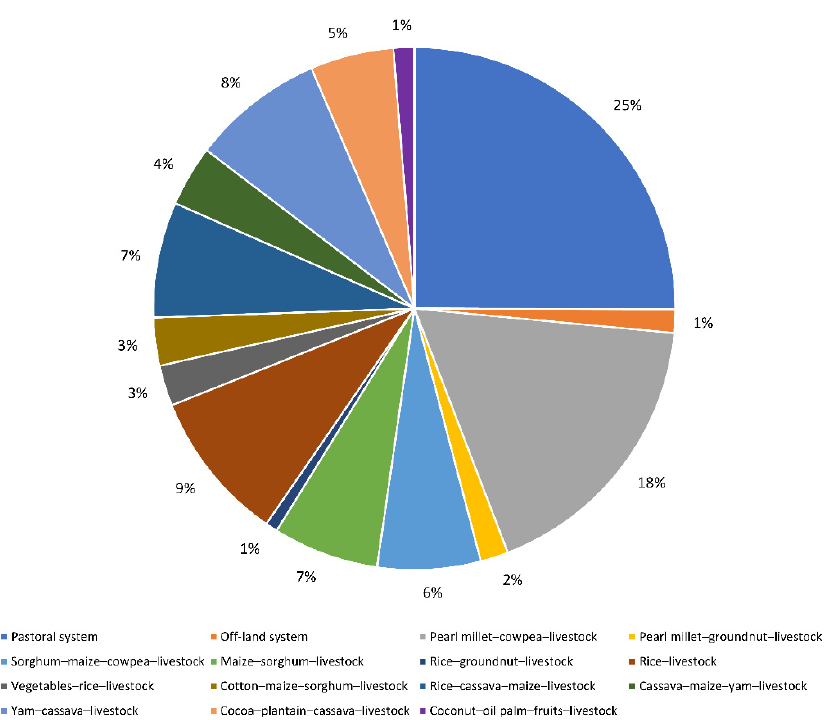
Figure 2. Percentage of the land area of different livestock farming systems in West Africa ([17]).